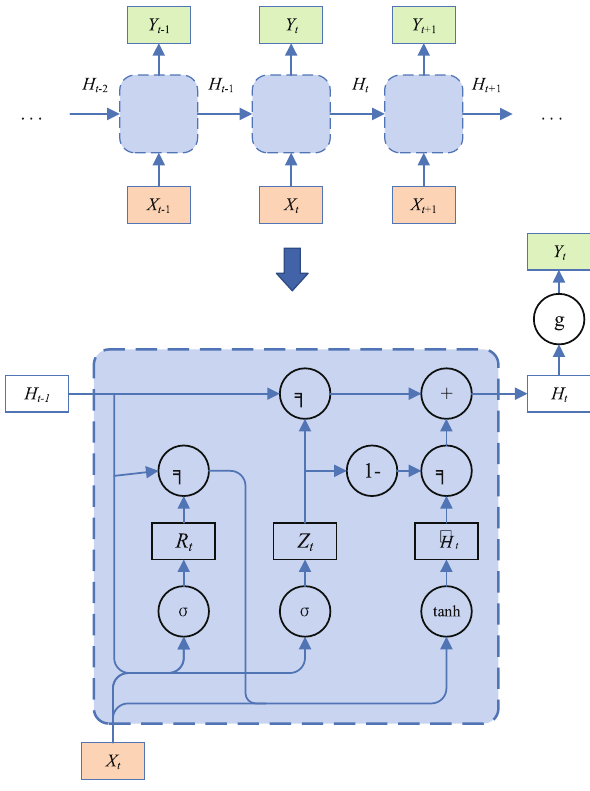
Figure 3: GRU structure